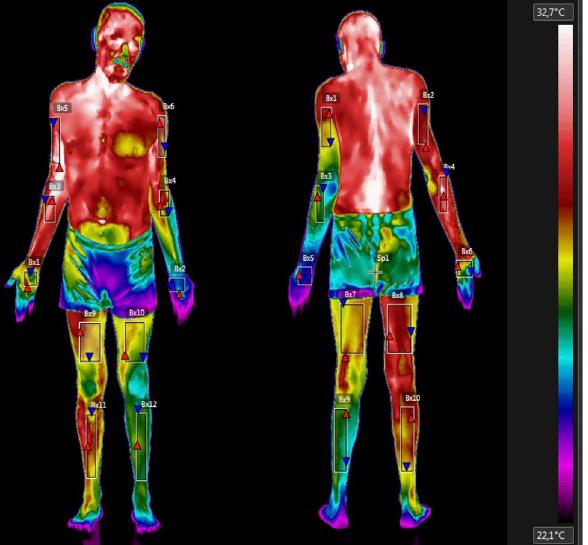
Figure 2. Thermographic image of the regions of interest (ROIs) of whole body. Figure obtained by the FLIR Tools software (https:// www. flir. com. br/ produ cts/ flir- tools/).